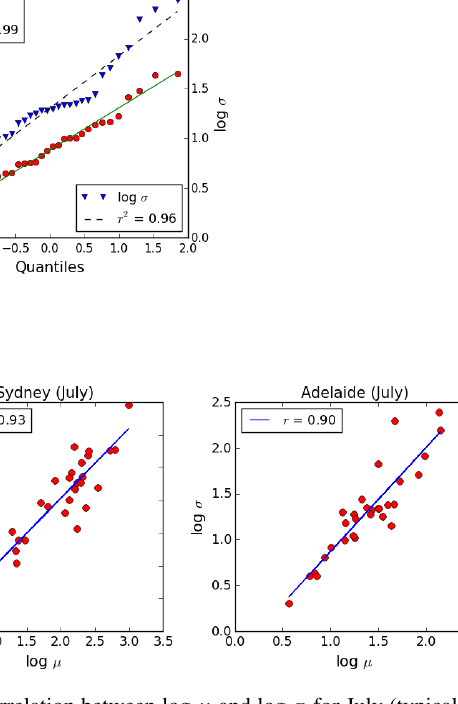
Figure 4. Correlation between log µ and log σ for July (typical of other